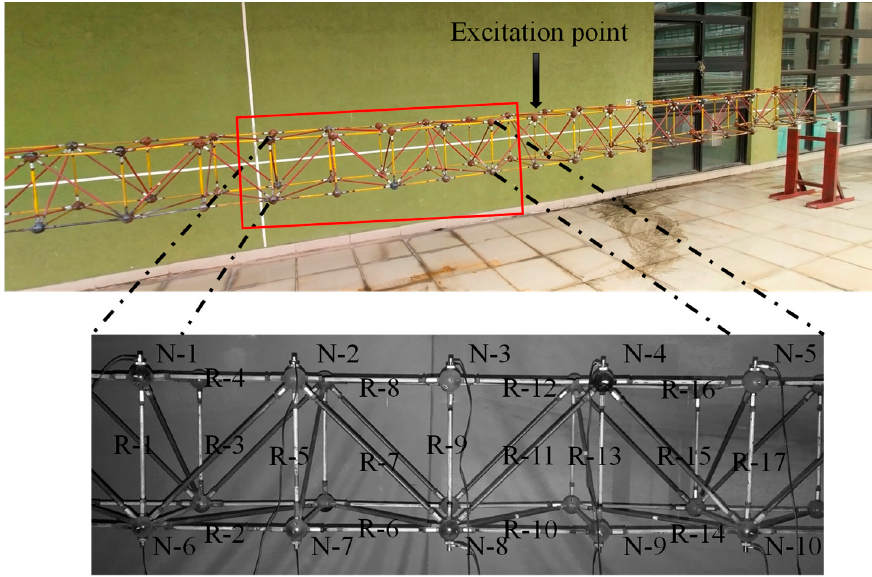
Figure 3. Location of excitation point and accelerometers. N-#: Installation point of accelerometers; R-#: Rods 1–17.